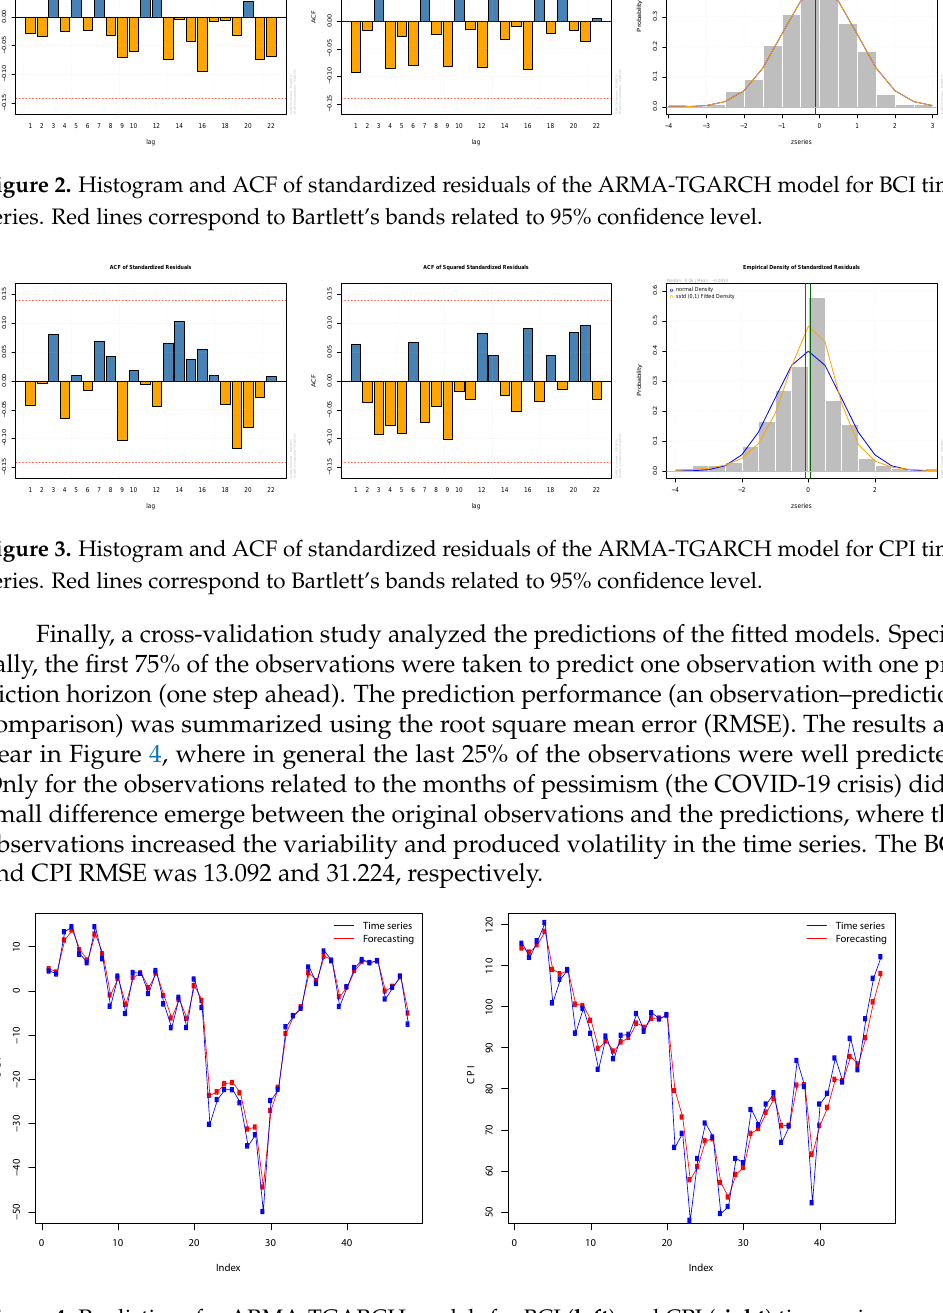
Figure 4. Predictions for ARMA-TGARCH models for BCI ( left ) and CPI ( right ) time